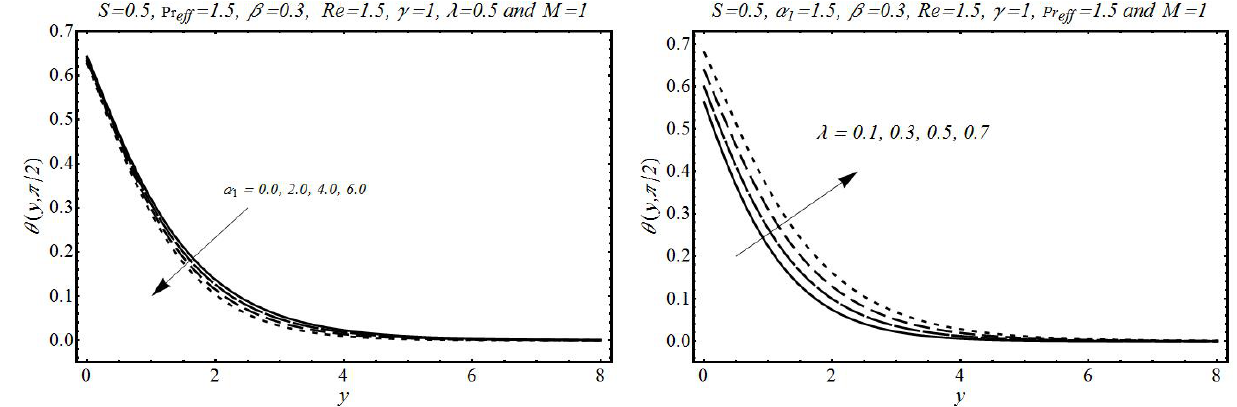
Figure 10: Effects of α 1 on temperature